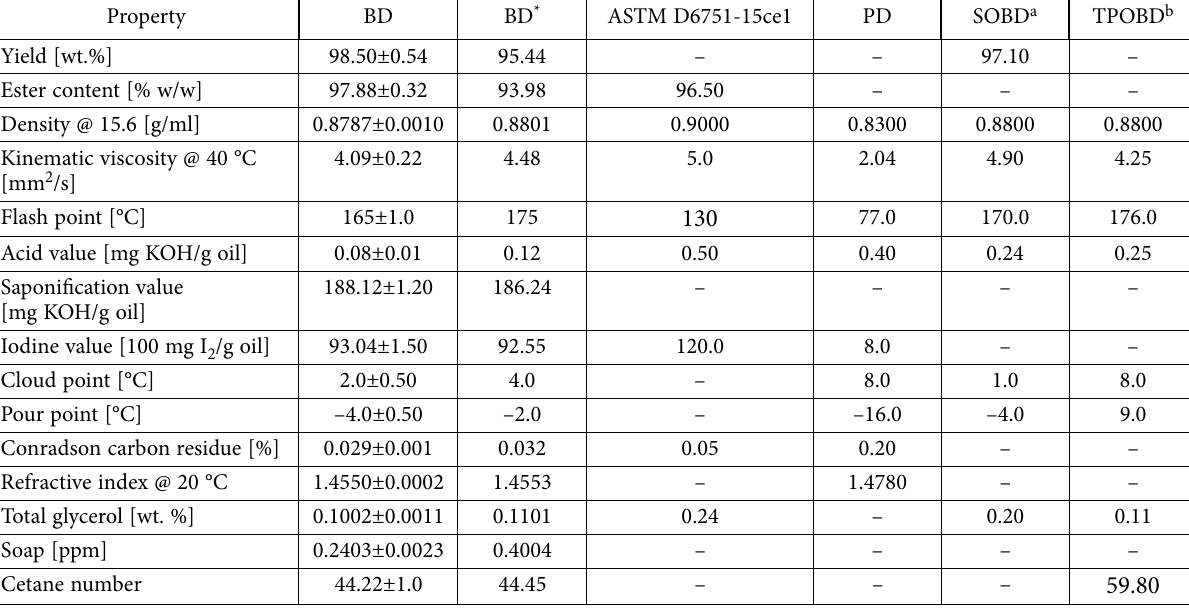
Table 3. Properties of BD produced from BAO compared to the standard BD and other BDs Property BD BD * ASTM D6751-15ce1 SOBD a TPOBD b Yield